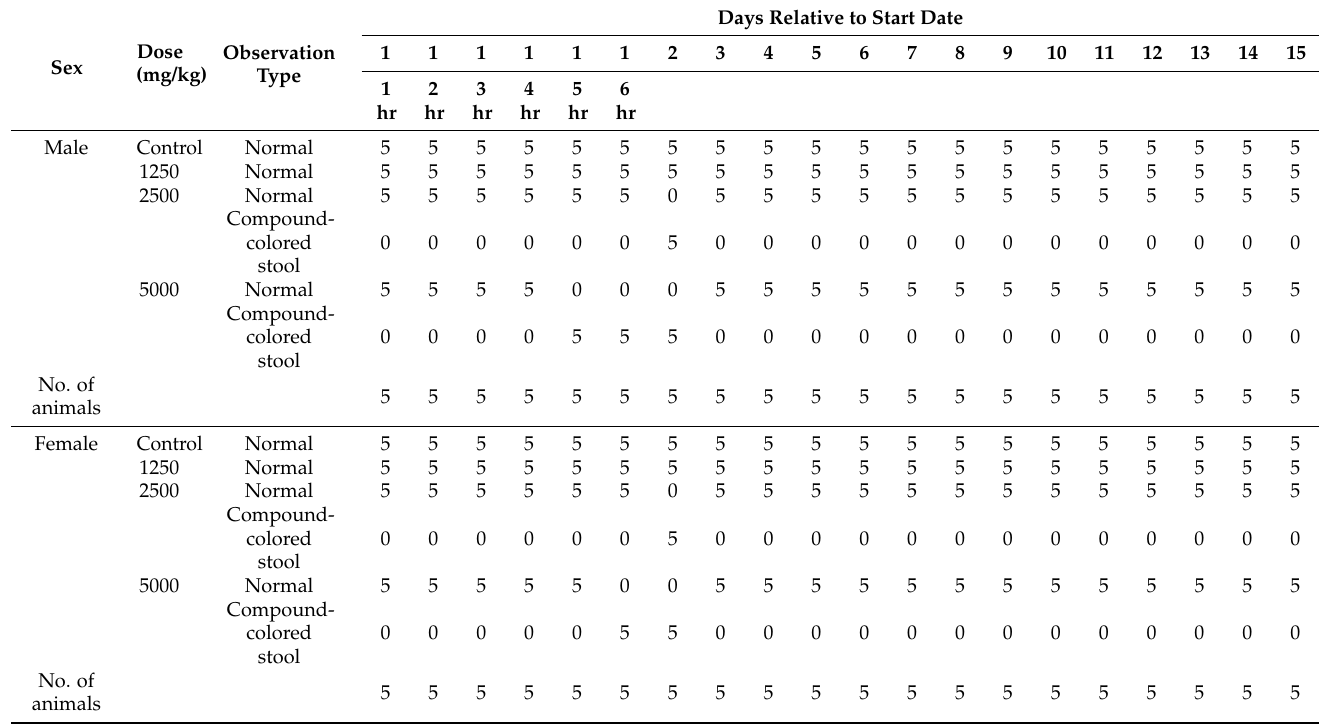
Table 2. Clinical signs in single oral dose toxicity of WG